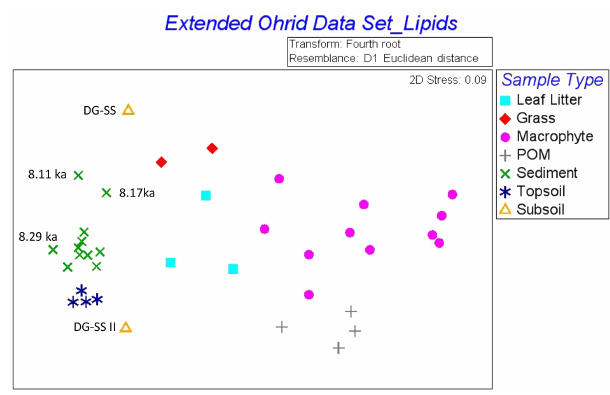
Figure 5. MDS plot showing separation of sample types in Eu- clidean space. For details see methodology Sect. 2.4. Low-carbon sediment samples are labelled with their age (ka). DG-SS and DG- SS II refer to the weathered and un-weathered subsoil samples (Terra Rossa) from site